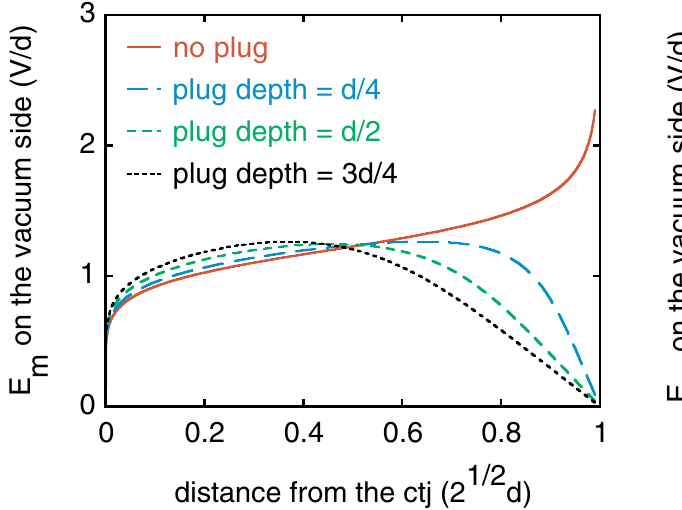
FIG. 8. (Color) The absolute value of the electric-field magni- on the vacuum side of an idealized 2D 45 (cid:1) vacuum- tude E m insulator interface, as a function of distance along the interface. The figure assumes that the dielectric constant of the insulator " (cid:8) 2 : 55 . The field is plotted for four different anode-plug depths. [The plot for the case with no plug is identical to that (vac) in Fig. 3.] The field is given in units of V=d , labeled E m where V is the voltage across the insulator and d is the insulator thickness as defined by Fig. 1. The distance from the ctj is given in units of 2 1 = 2 d , which is the total length of the vacuum- insulator